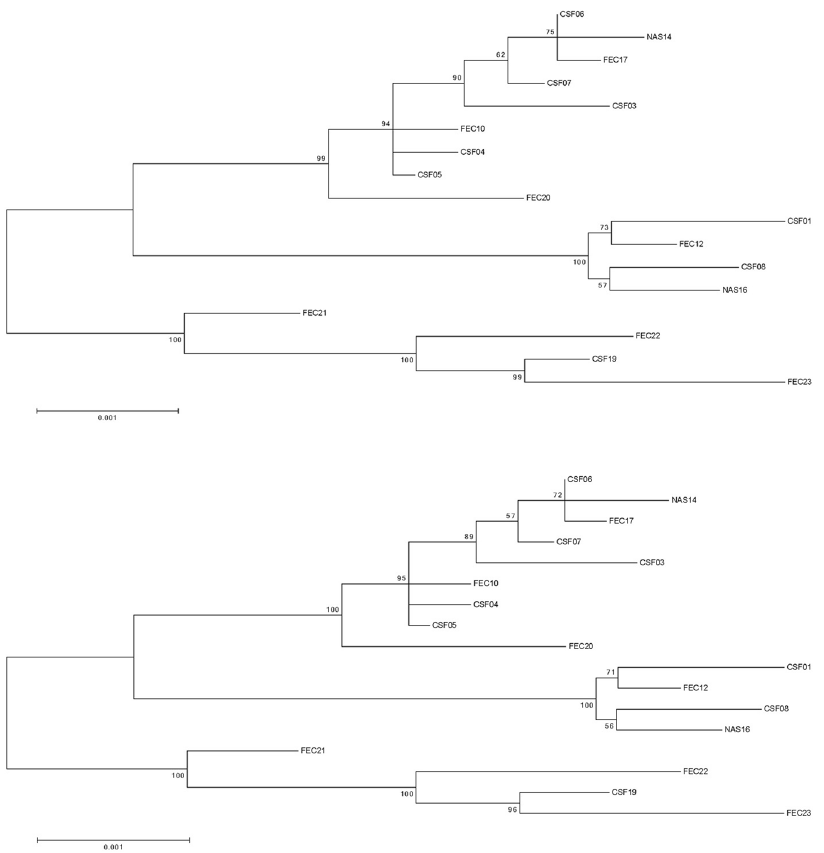
Figure 3. Maximum Likelihood (ML) phylogenetic trees based on the either the full open reading frame from nucleotide 701–7231 or the full length sequence from nucleotide 1–7334 of the 17 Australian 2013–2015 HPeV3 sequences. Sequences were aligned using Clustal W and phylogenetic analysis was conducted using MEGA version 6 and the Maximum Likelihood (ML) method. The tree with the highest log likelihood is shown. Bootstrap test involved 1000 replicates to determine reliability of the inferred tree. The numbers at nodes represent bootstrap values. Branch lengths are scaled according to the numbers of nucleotide substitutions per site. (A) Midpoint rooted tree based on the full open reading frame from nucleotide 701–7231. (B) Midpoint rooted tree based on the full length sequence from nucleotide